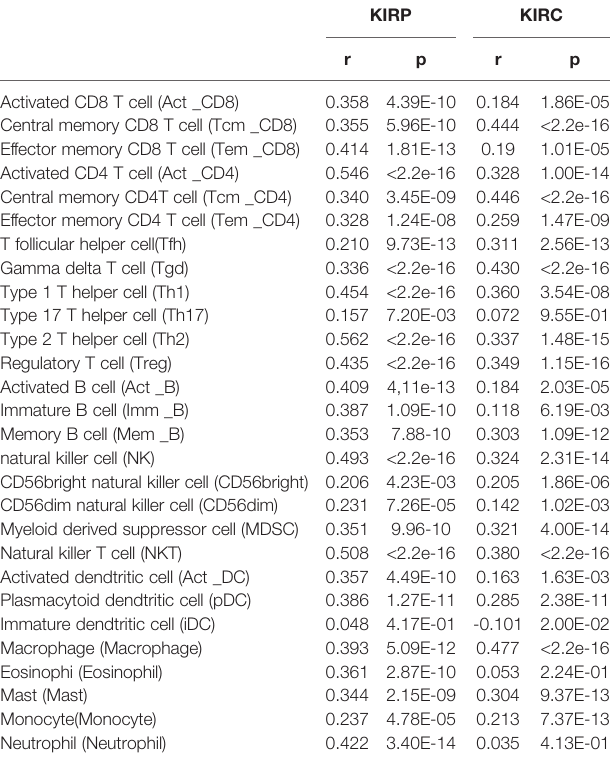
KIRP KIRC r p r p